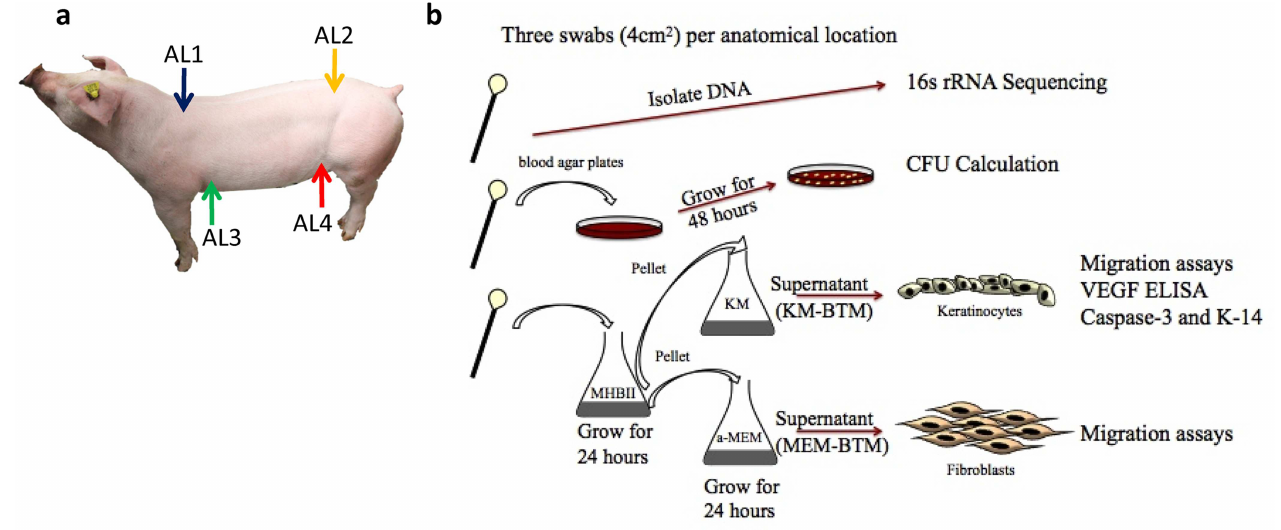
Fig 1. Methods Summary (a) Schematic of swabbinglocations. (b) Graphical representation of methods